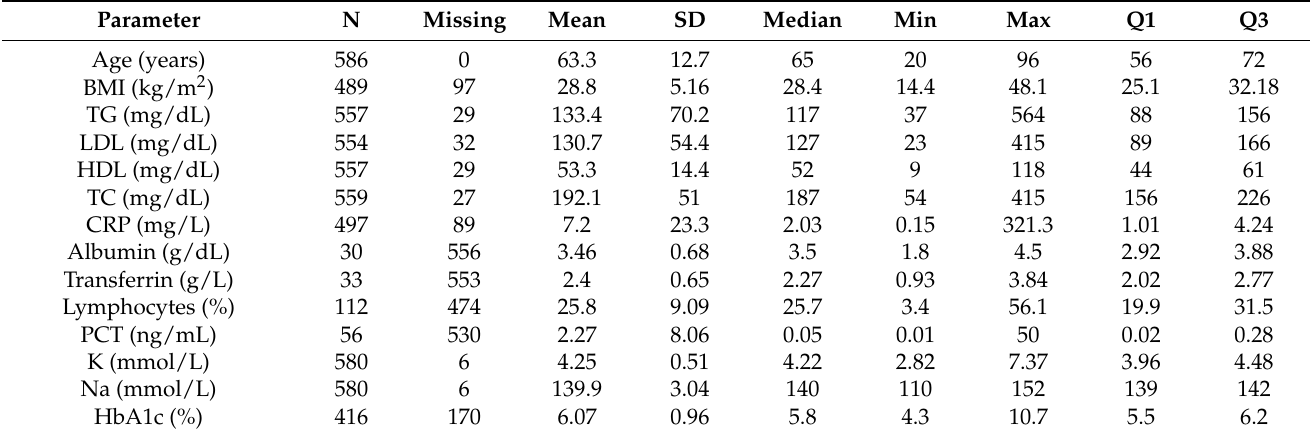
Table 2. Study group characteristics (quantitative